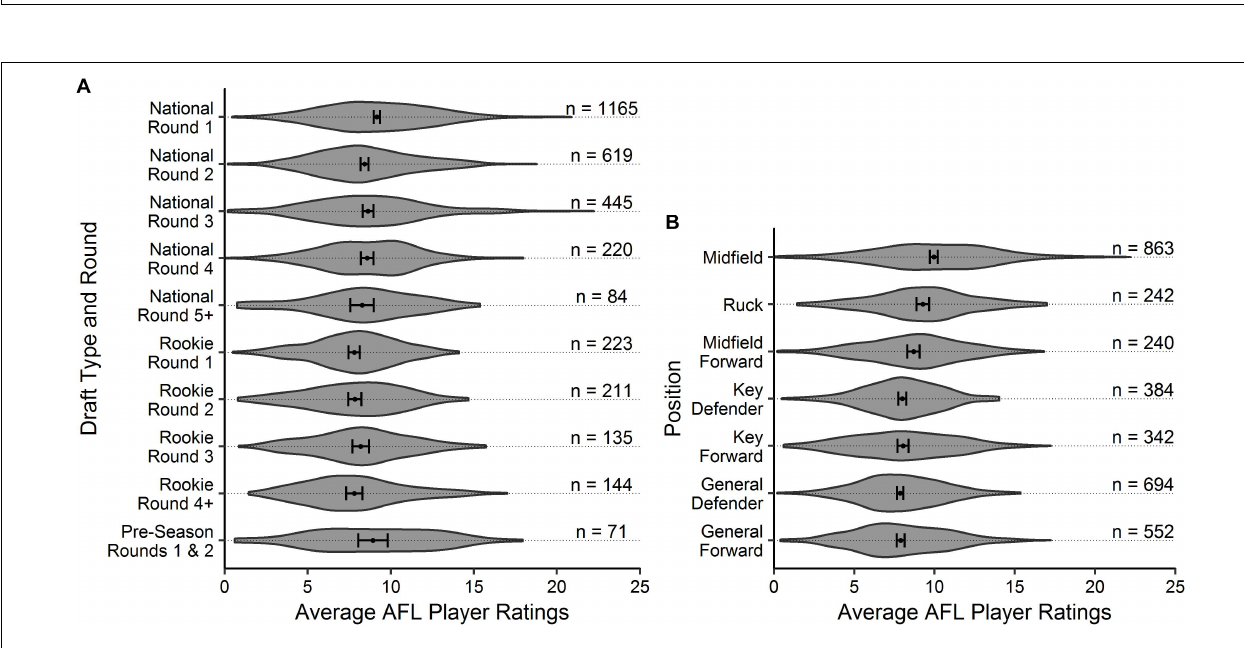
FIGURE 2 | Violin plot outlining the density of the average AFL Player Ratings ( ± 95% CI) for (A) draft and (B) positional role, respectively. The number of observations in each group are outlined.